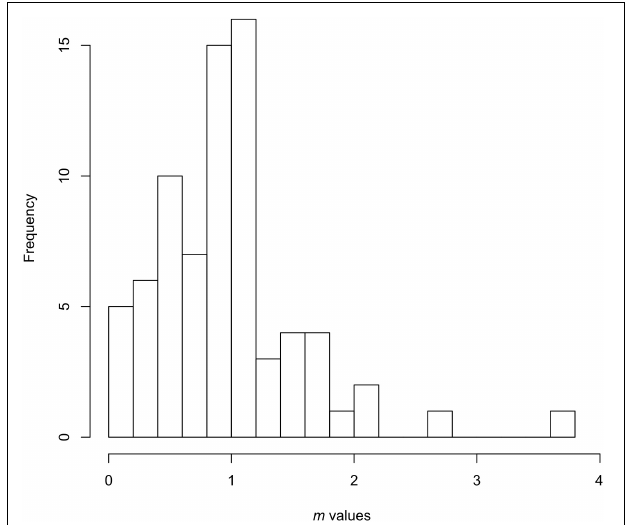
FIGURE 1 | Values of the consumer interference parameter m estimated from the literature by Novak and Stouffer (2021), as defined by the consumer-dependent model of Arditi and Akçakaya (1990). The 75 cases range in value from 0.034 to 3.79 (two cases where the authors were unable to obtain reasonable standard errors have been omitted). The truncation at 0, positive skew, and a modal value near to but less than 1 are